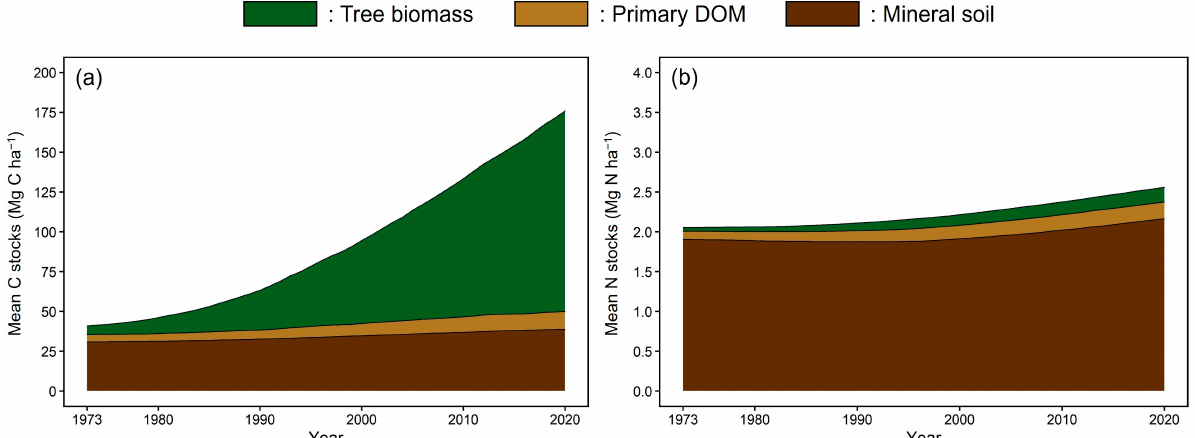
Figure 4. Dynamics of the simulated mean ( a ) C stocks and ( b ) N stocks of tree biomass, primary dead organic matter (DOM), and mineral soil across the South Korean forests from 1973 to 2020.